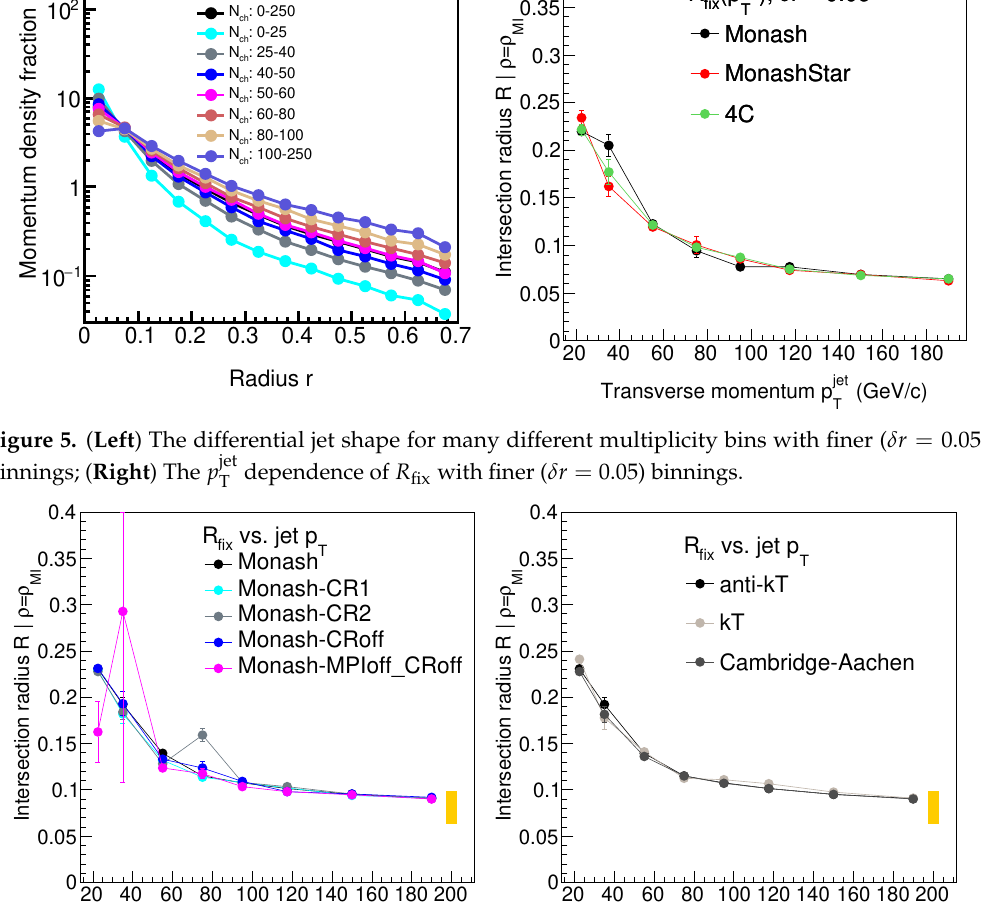
for different settings ( left ); and for different jet T